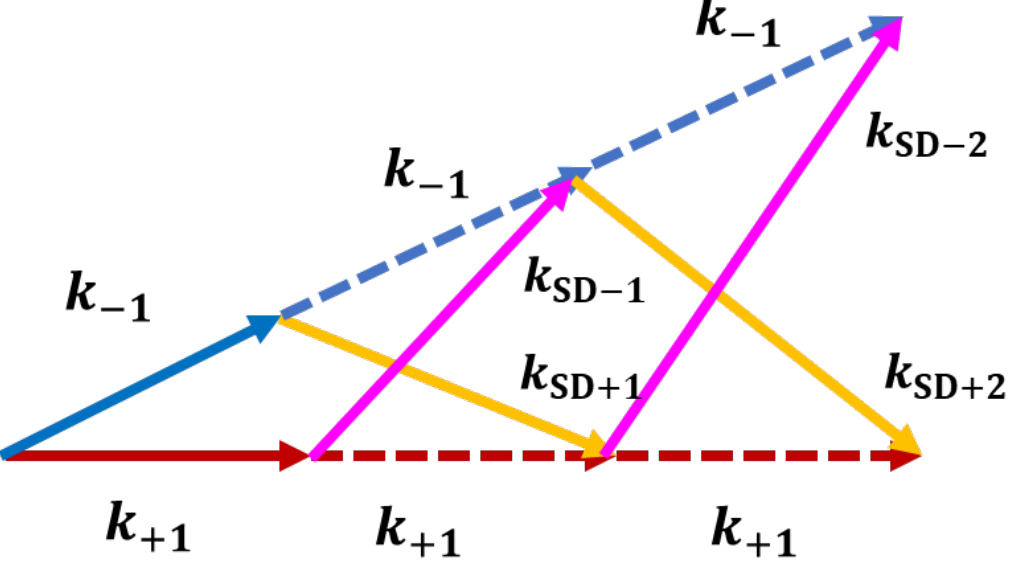
Figure 1. Phase-matching geometry of the SD process. θ is the incident crossing angle; k + 1 and k − 1 Figure 1. Phase- matching geometry of the SD process. θ is the incident crossing angle; 𝑘 +1 and are wavevectors of the two incident beams, k SD ± 1 and k SD ± 2 are the first-order and second-order SD 𝑘 𝑘 𝑘 signals generated, −1 are wavevectors of the two incident beams, 𝑆𝐷±1 and 𝑆𝐷±2 are the first-order and second-or- der SD signals generated, respectively.